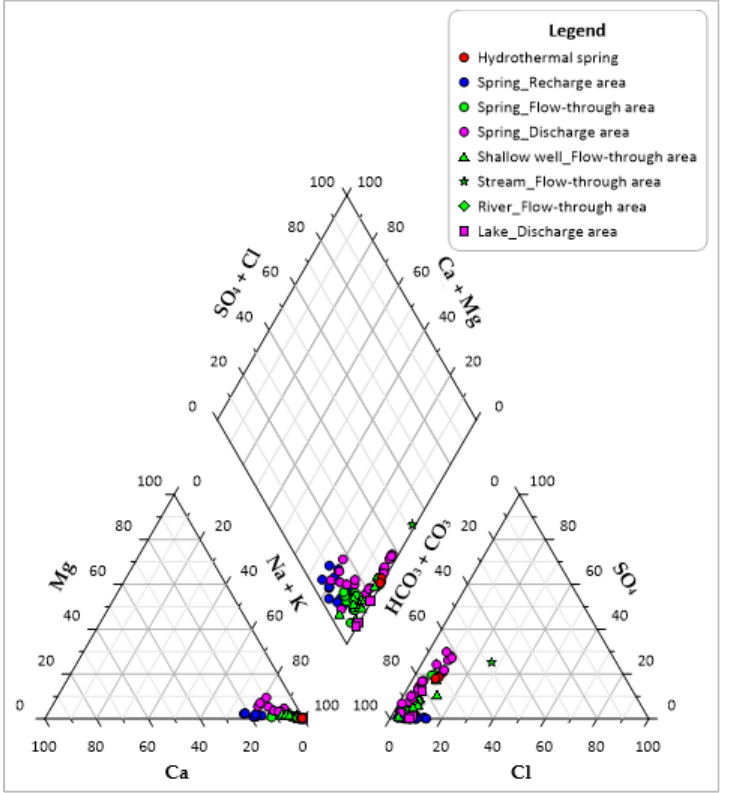
Figure 9. Piper diagram showing different water samples taken from springs, shallow wells, stream, river, and lakes on the eastern and northeastern flanks.